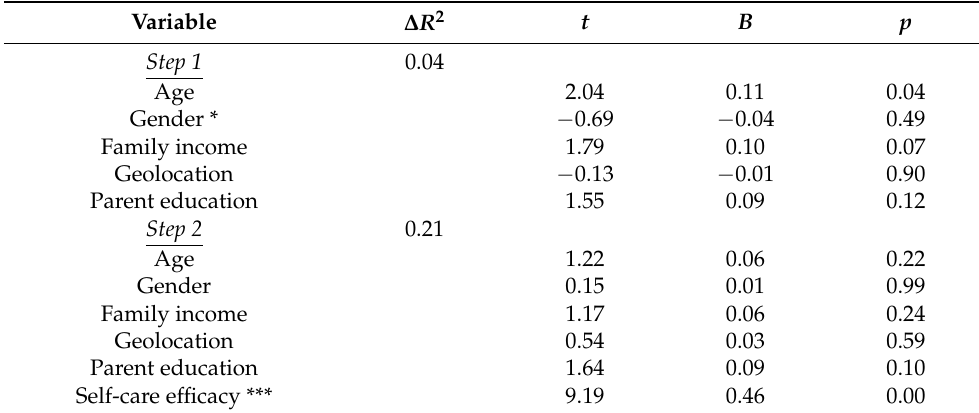
Table 5. Hierarchical regression estimates predicting mental health in the face of schoolwork